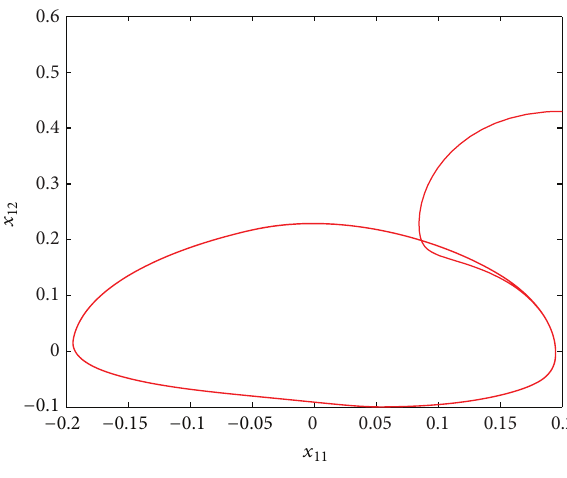
Figure 1: Phase response of state variables 𝑥 11 , 𝑥 12 in Example 1.